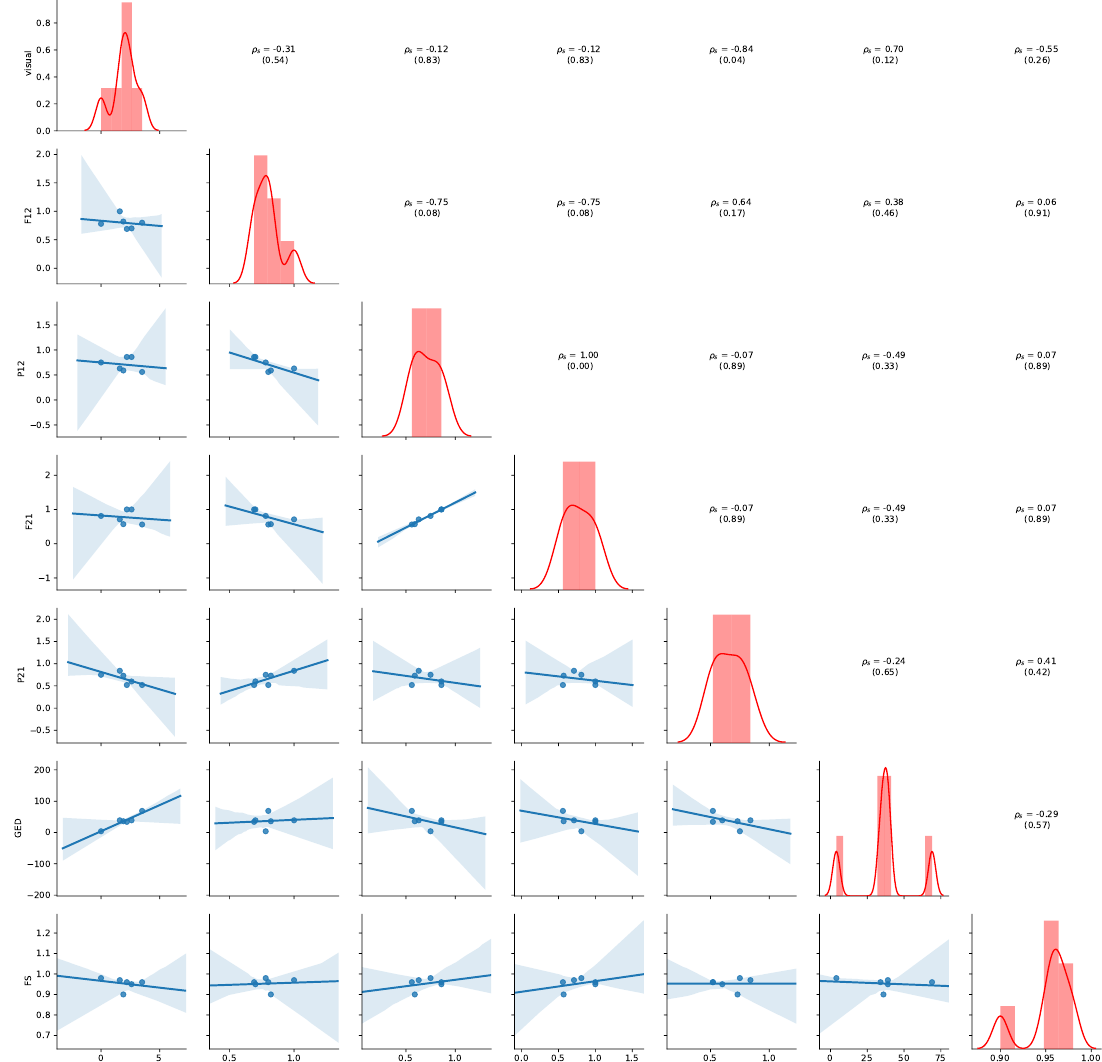
Figure A4. Relation of non-aggregated measures for ZGT. Based on measures reported in Table 7. Diagonal: normalized histogram and kernel density estimation of the distribution. Lower triangle: scatterplot with estimated linear regression line. Upper triangle: pairwise Spearman’s rank correlations with p